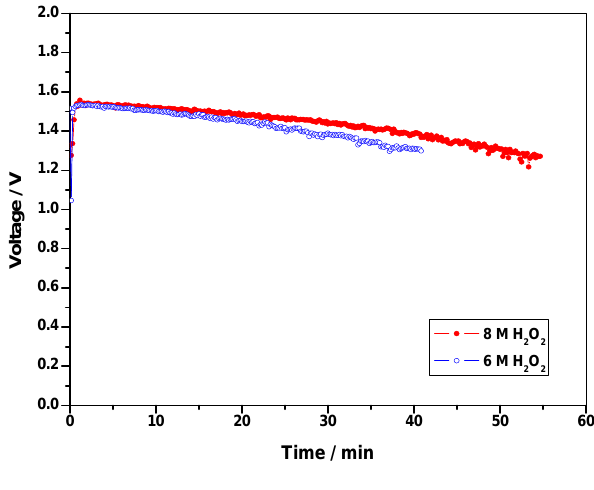
Figure 3. Performance data for the DBFC with 6 M and 8 M H SO as catholyte and 8 wt. % NaBH H 2 4